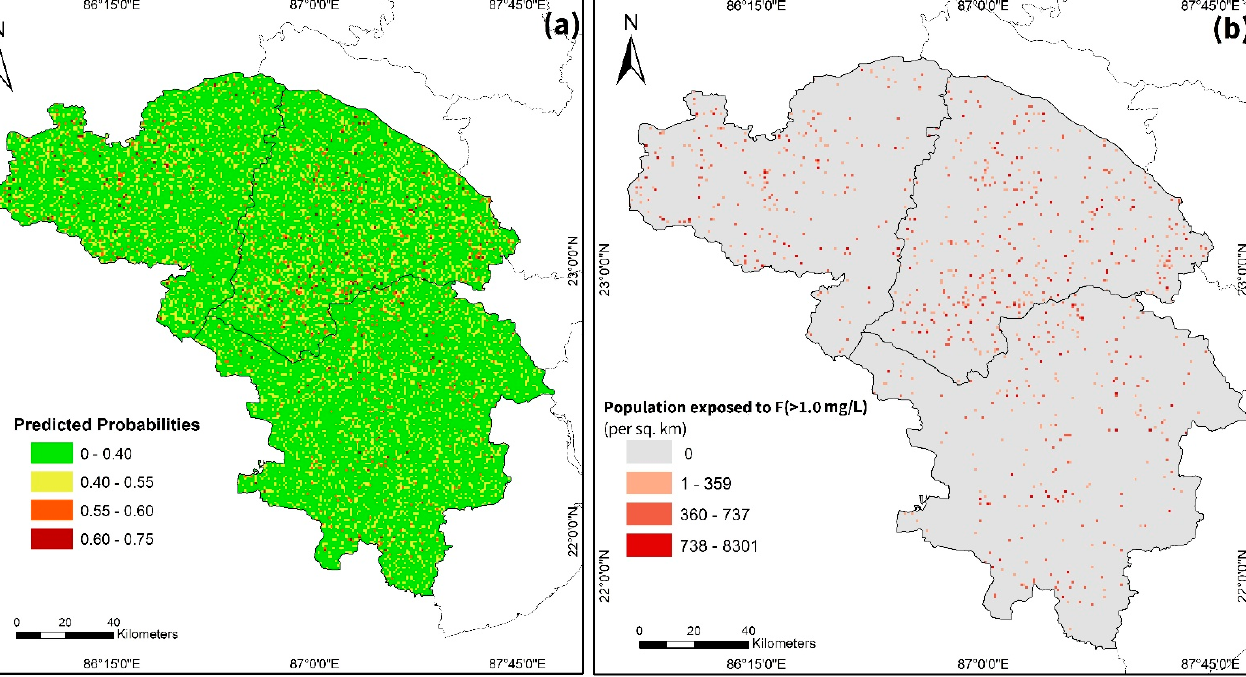
Figure 4. ( a ) Map showing the accuracies of the groundwater F prediction; ( b ) mean decrease in accuracy of the predictor variables: PET—Potential Evapotranspiration, TWI—Topography Wet- ness Index, HC—Hydraulic Conductivity, WT—Depth to Water Table, and CEC—Cation Exchange Capacity.